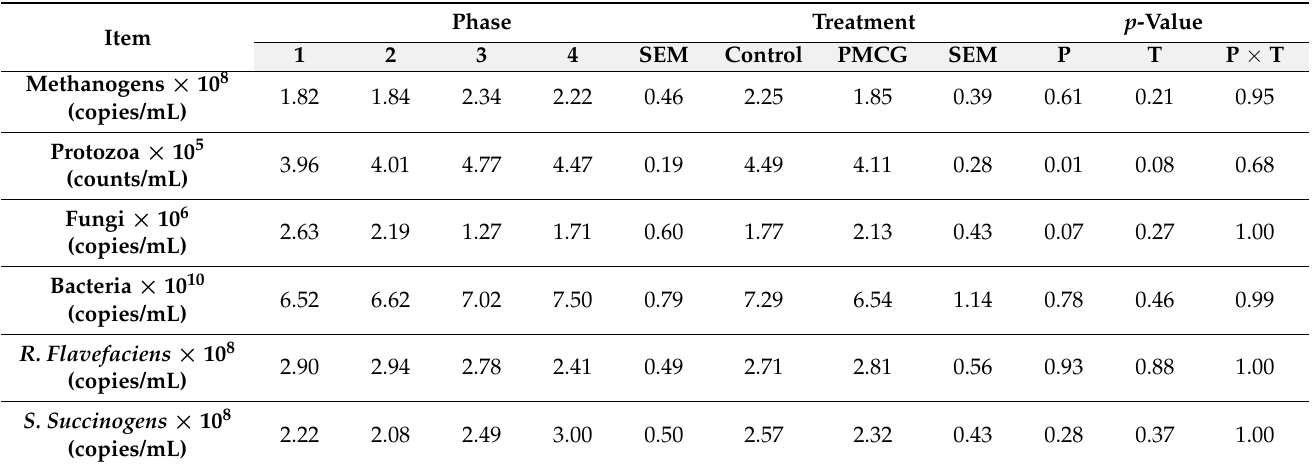
Table 5. Effects of PMCG on the rumen microbial